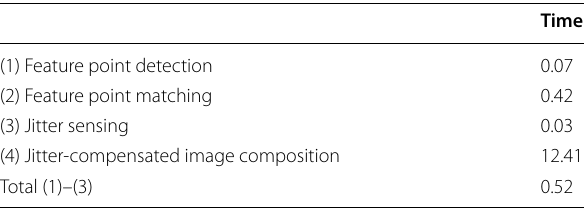
Table 1 Execution times on our hybrid camera